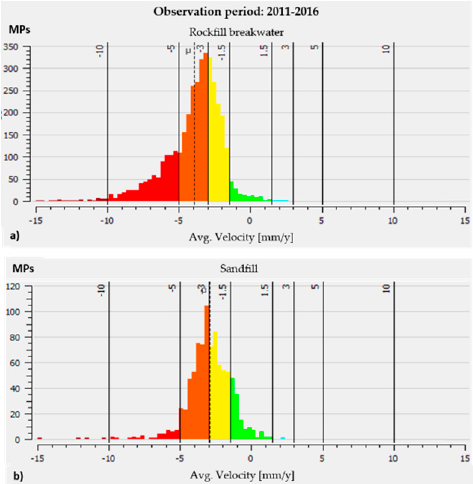
Figure 13 . Histograms representing the average LOS velocity of MPs for the entire rockfill area ( a ) and the sand fill area ( b ) over the entire observation period. The colors indicate the amount of displacement. Specifically, green points are considered stable (average LOS velocity between 1.5 and − 1.5 millimeters per year), while yellow to red color are referred to as a movement away from the satellite sensor (i.e., in this specific case is associated to settlements). µ (dashed red line) is the average LOS velocity.